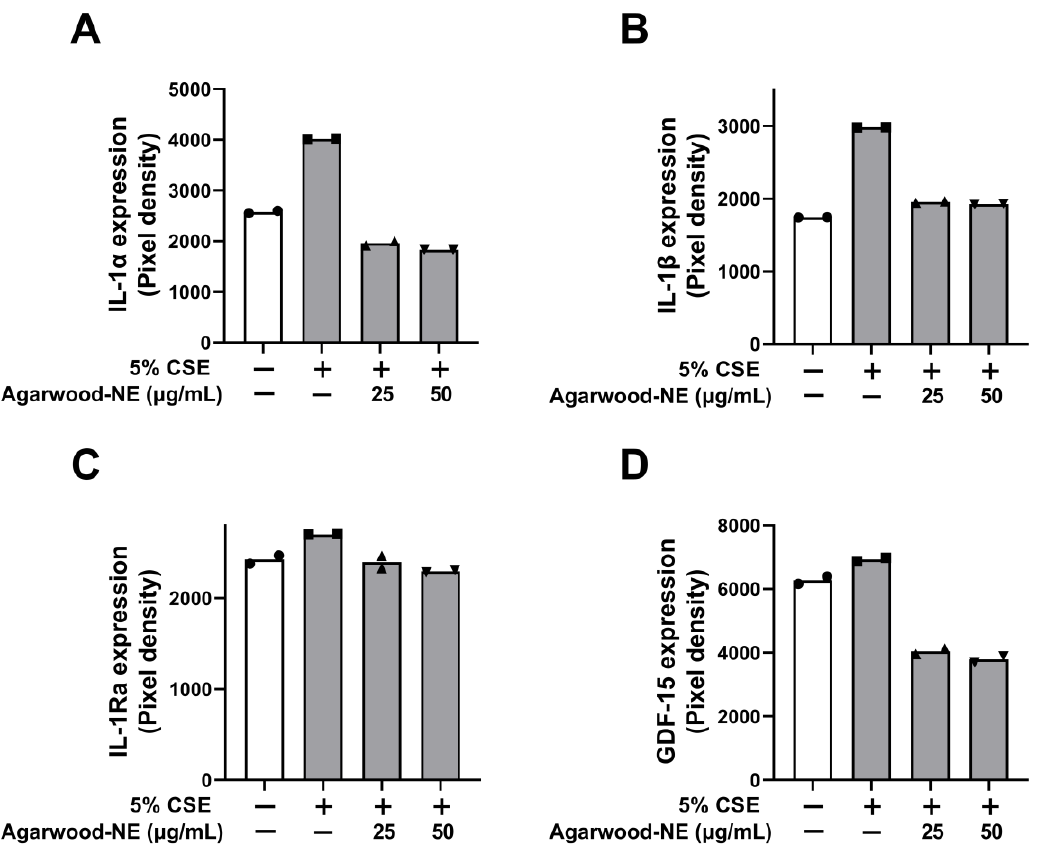
Figure 3. Effect of Agarwood-NE on the CSE-induced production of pro-inflammatory mediators in human cytokine protein array. BCi-NS1.1 cells were pre-incubated for 1 h in the presence of 25 and 50 µ g/mL agarwood-NE, followed by exposure to 5% CSE for 24 h. The protein levels of IL-1 α ( A ), IL-1 β ( B ), IL-1Ra ( C ), and GDF-15 ( D ) were determined via human cytokine protein array.